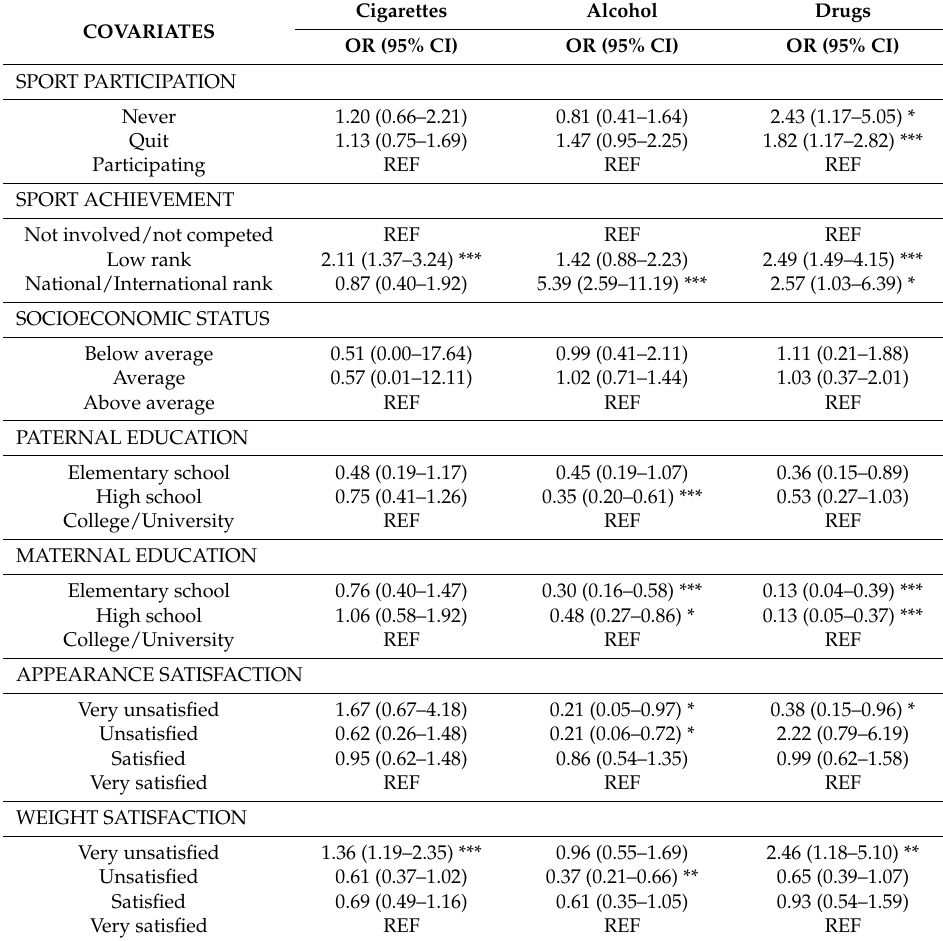
Table 2. Logistic regression calculations for Bosniak